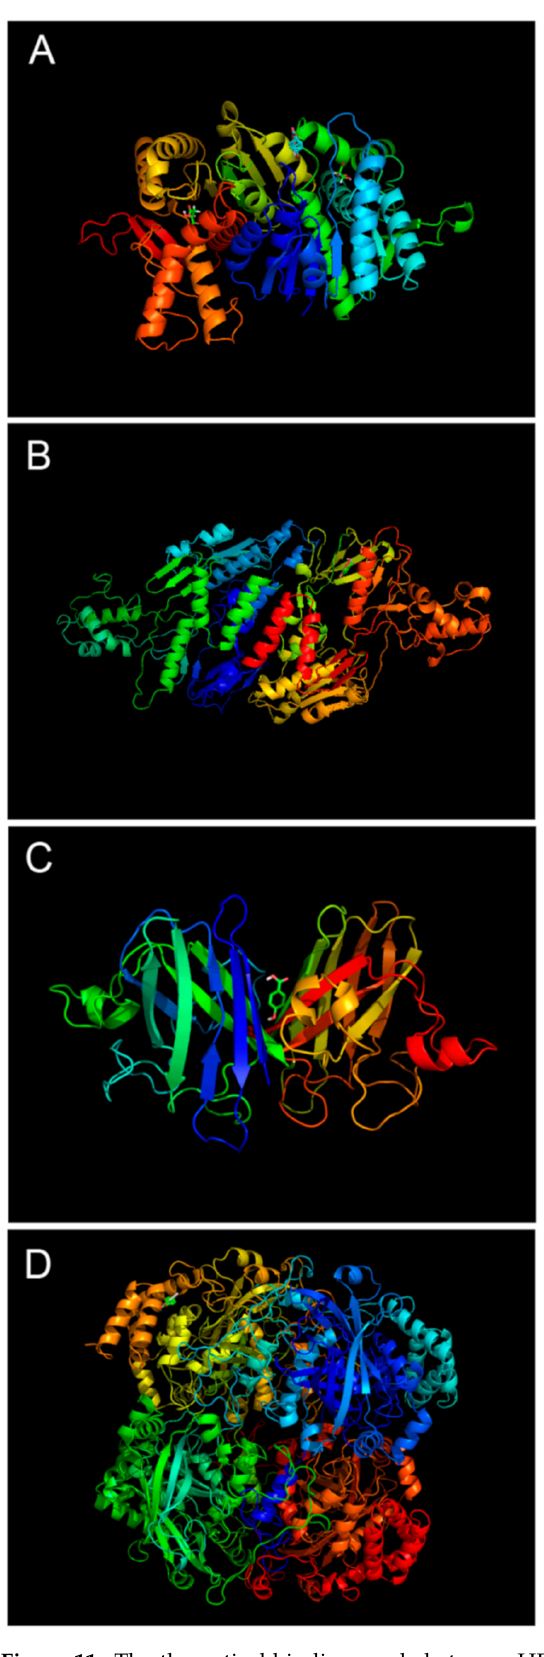
Figure 11. The theoretical binding mode between HBA and target enzymes and the result were shown by PyMoL 1.7.6. Notes: ( A ): binding complex of HBA and MDH; ( B ): binding complex of HBA and NADH oxidase; ( C ): binding complex of HBA and SOD; ( D ): binding complex of HBA and